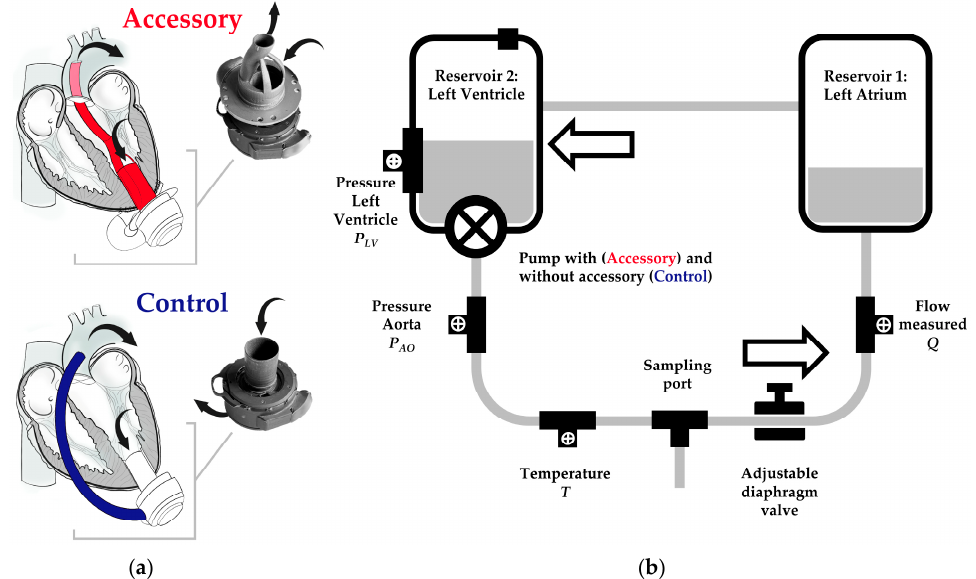
Figure 1. ( a ) Centrifugal- fl ow left ventricular assist device (LVAD) with and without accessory and ( b ) mock circulatory loop (MCL) schematic. ( a ) The accessory combines the LVAD’s in fl ow and out- fl ow. Blood from the left ventricle enters the LVAD through the accessory’s in fl ow (lower arrow).